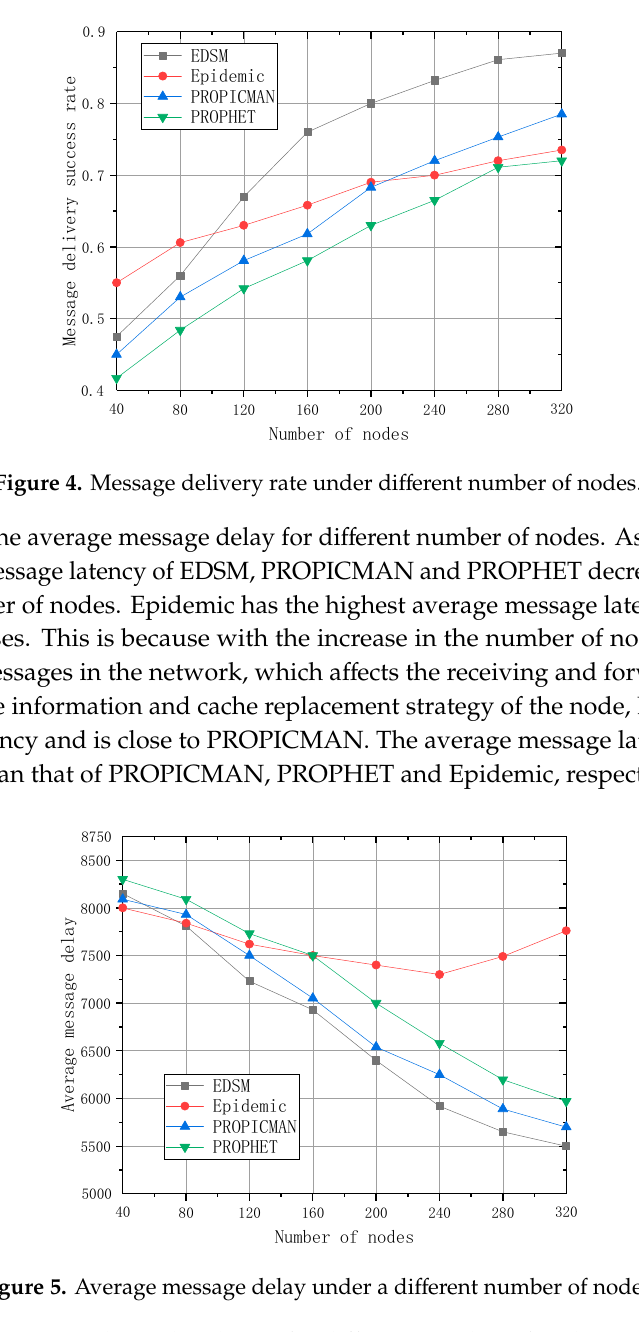
Figure 6. Network overhead ratio under different number of nodes. Figure 7 depicts the success rate of message delivery in different cache spaces. From the graph, we can see that the success rate of the message delivery of the four algorithms increases with the increase in buffer space, and the growth rate gets lower and lower. EDSM has the highest message delivery success rate.